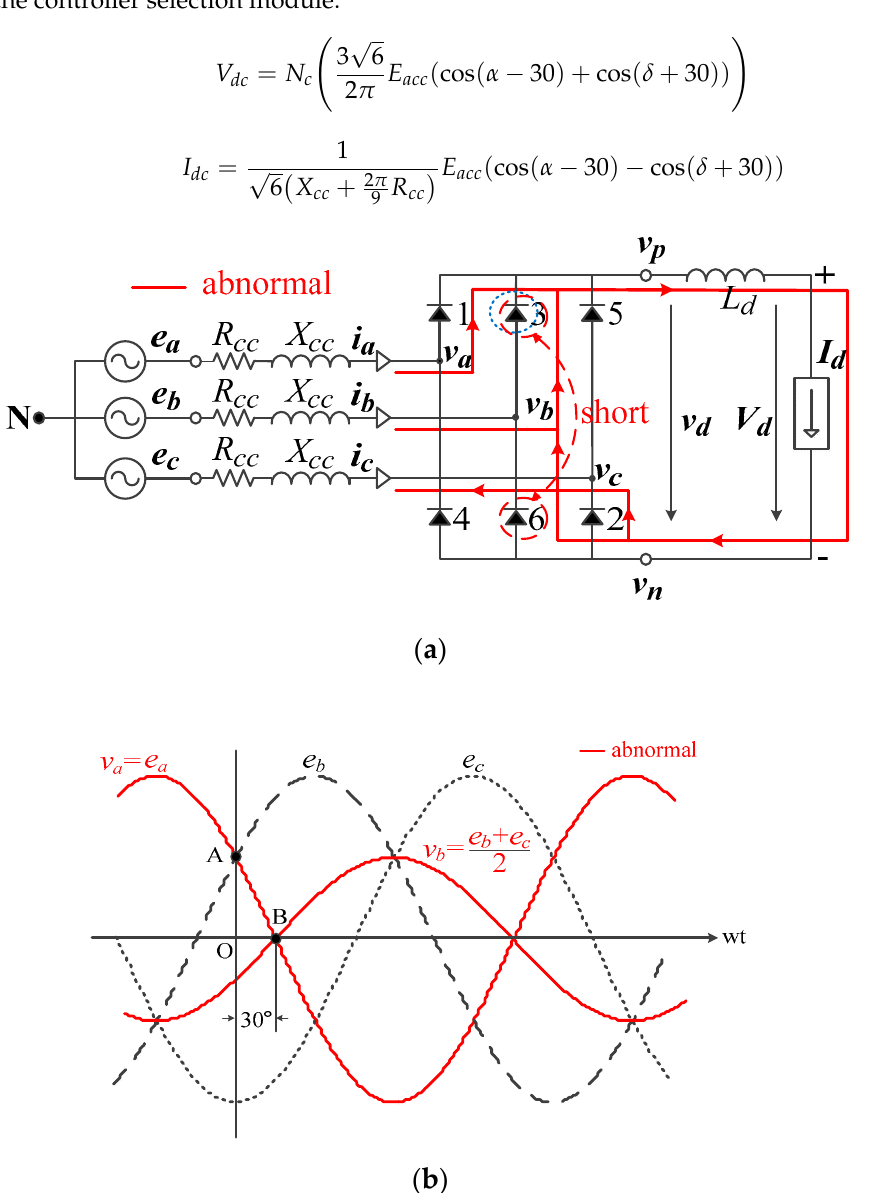
Figure 6. ( a ) Schematic diagram and ( b ) instantaneous voltages of the three-phase converter during the abnormal operation.